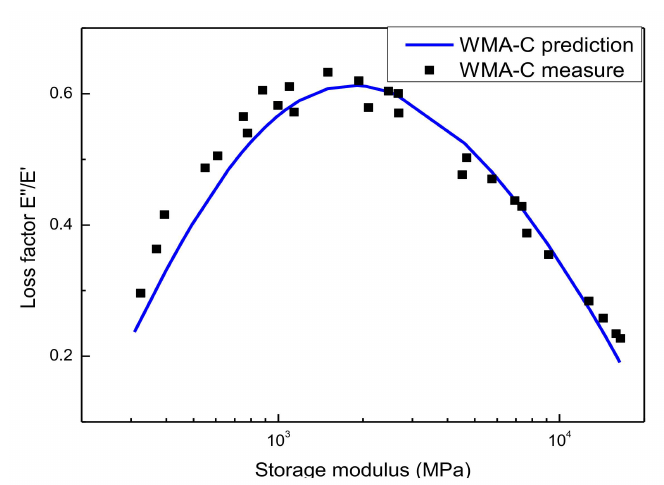
Figure 16. The Black space diagram of the asphalt mixture.